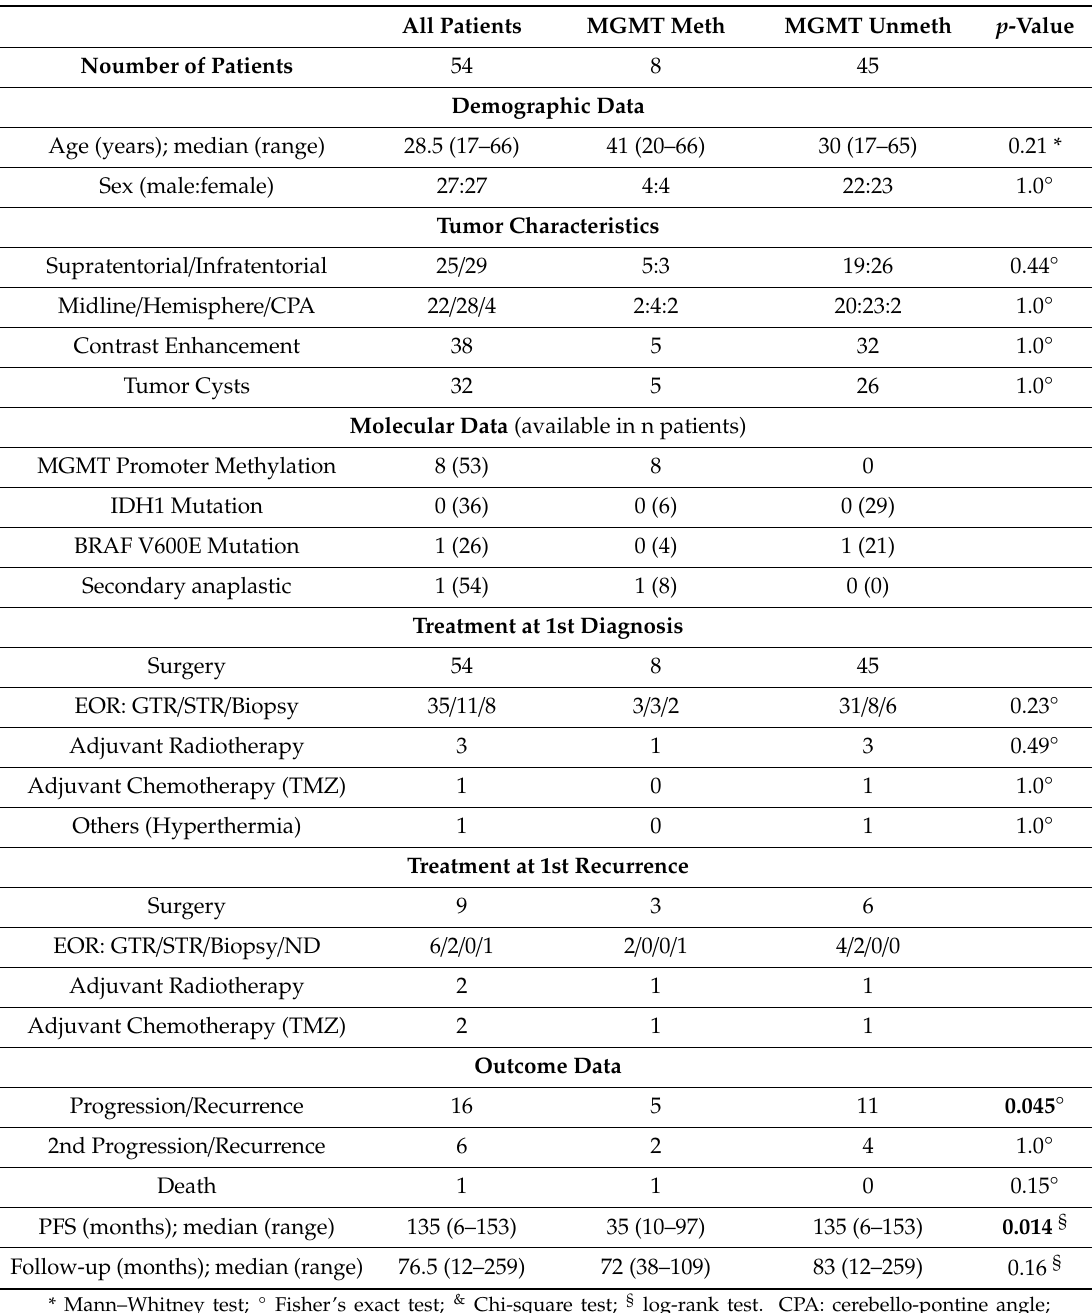
Table 3. Patient characteristics of the outcome cohort (n = 54); stratified for MGMT promoter methylation